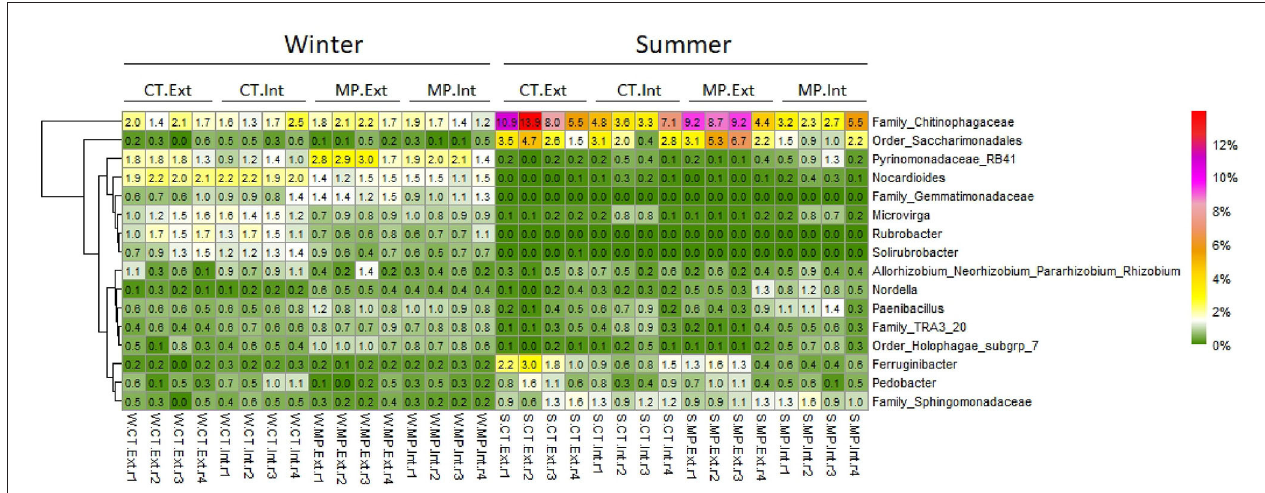
FIGURE 3 | Heatmap displaying the relative abundance distribution of bacterial genera (responder) significantly affected (FDR < 0.05) by different long-term management practices (CT, Cultivator Tillage vs. MP, Moldboard Plow; Int, intensive vs. Ext, extensive) in soils sampled in LTE Bernburg in winter (W) or summer (S). Most abundant responders with average ( n = 4) relative abundance per treatment > 0.5% are shown. Pairwise comparisons between treatments are presented in Supplementary Tables 4, 5